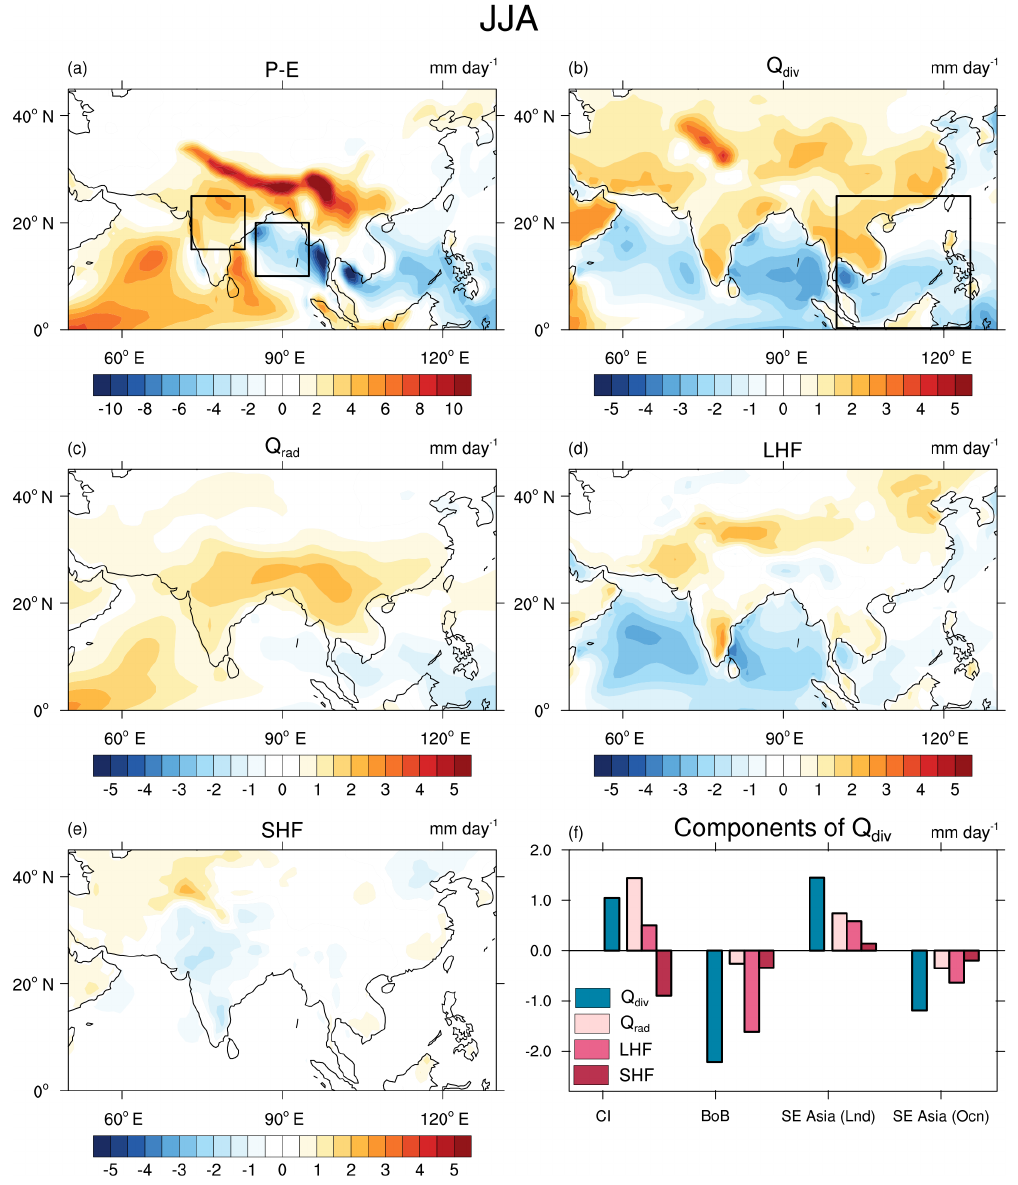
Figure 8. The JJA mean difference ( P min − P max ) in (a) P − E , (b) Q div (sum of energy fluxes at the top and bottom of the atmosphere), (c) Q rad (sum of all radiative fluxes at the top and bottom of the atmosphere), (d) latent heat flux, and (e) sensible heat flux. The boxes shown in (a) and (b) are the regions chosen for this study: central India (15–25 ◦ N; 73–83 ◦ E), the Bay of Bengal (10–20 ◦ N; 85–95 ◦ E), and Southeast Asia (0–25 ◦ N; 100–125 ◦ E). (f) shows the decomposition of Q div into radiative, latent, and sensible heat fluxes for the two